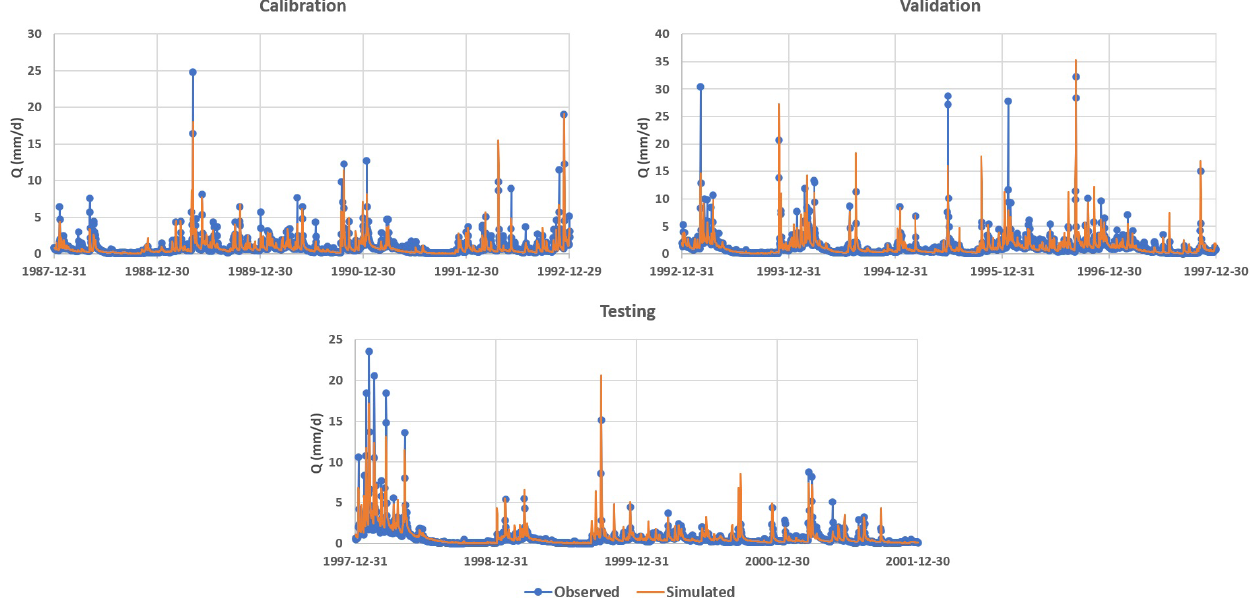
Figure 9. Simulated hydrograph of MIKA-SHA_FUSE with the observed hydrograph of the basin.